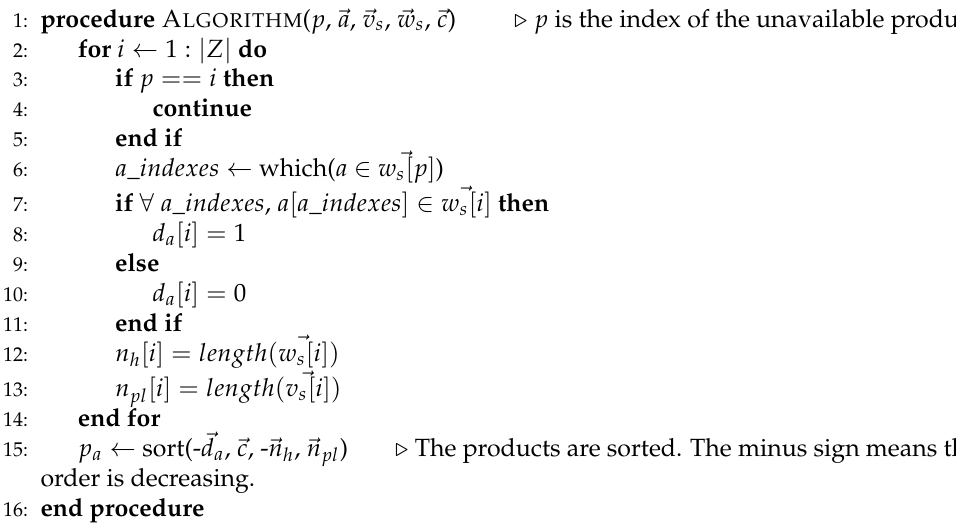
Algorithm 3 HTH-BD approach of RS-CF: Algorithm